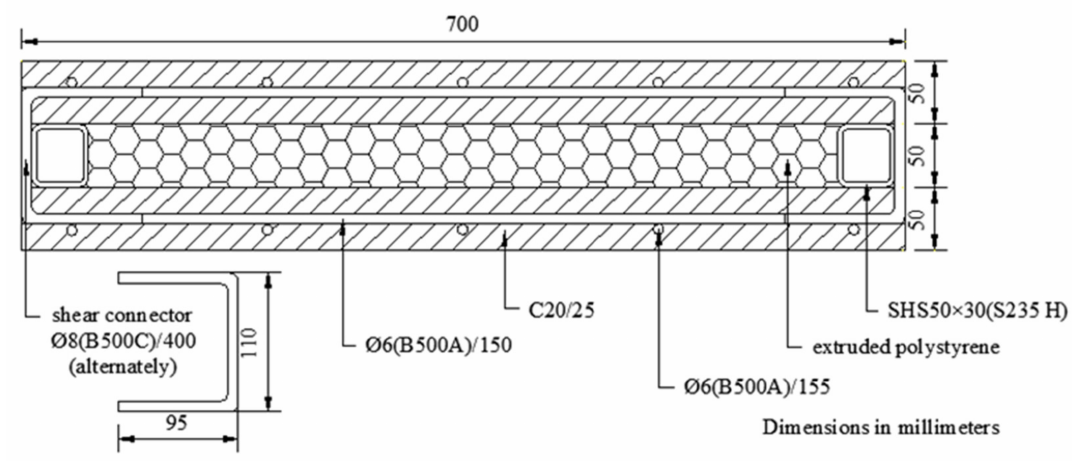
Figure 1. Geometrical details of the PCSP-1 cross-section [19,20].